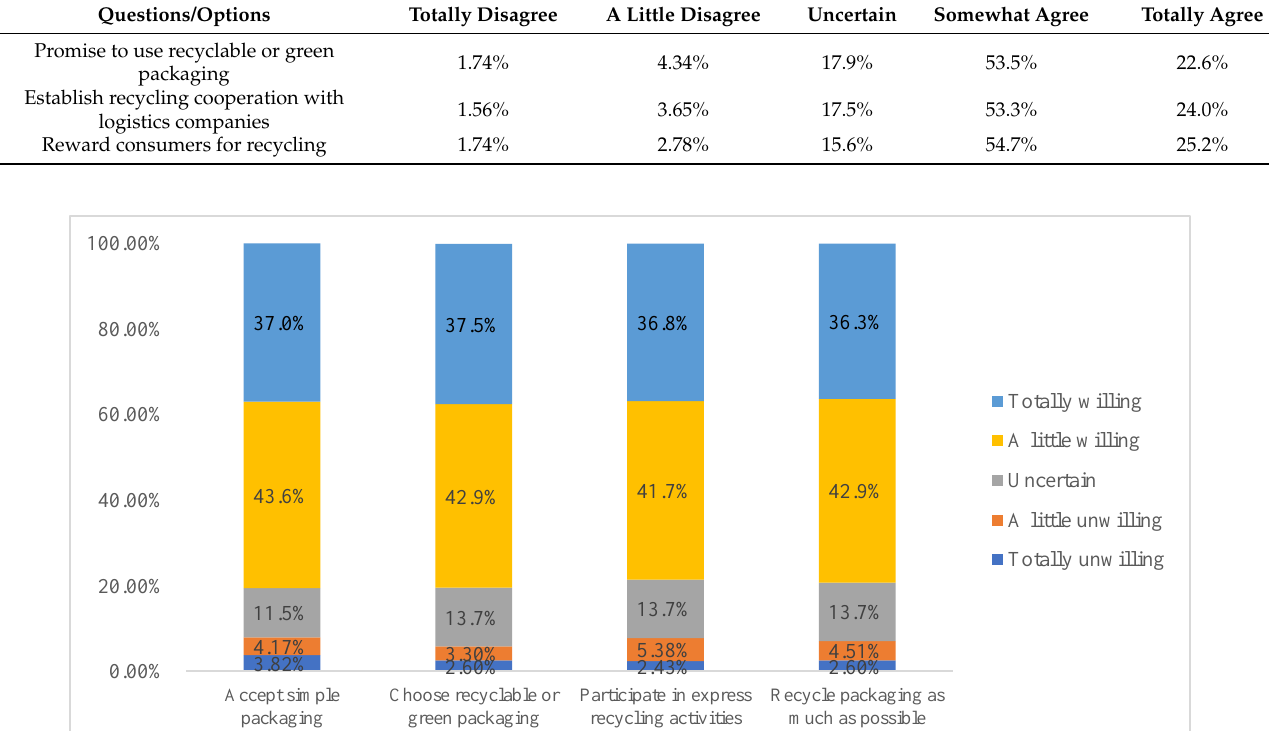
Figure 5. Consumers’ willingness to protect the environment.